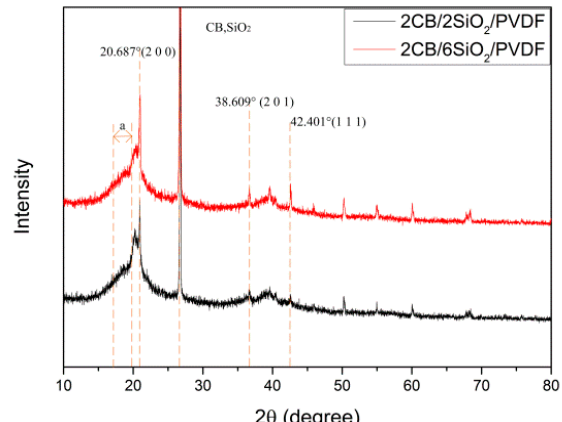
Figure 11. X-ray diffraction (XRD) curve of CB/SiO 2 /PVDF composite film.